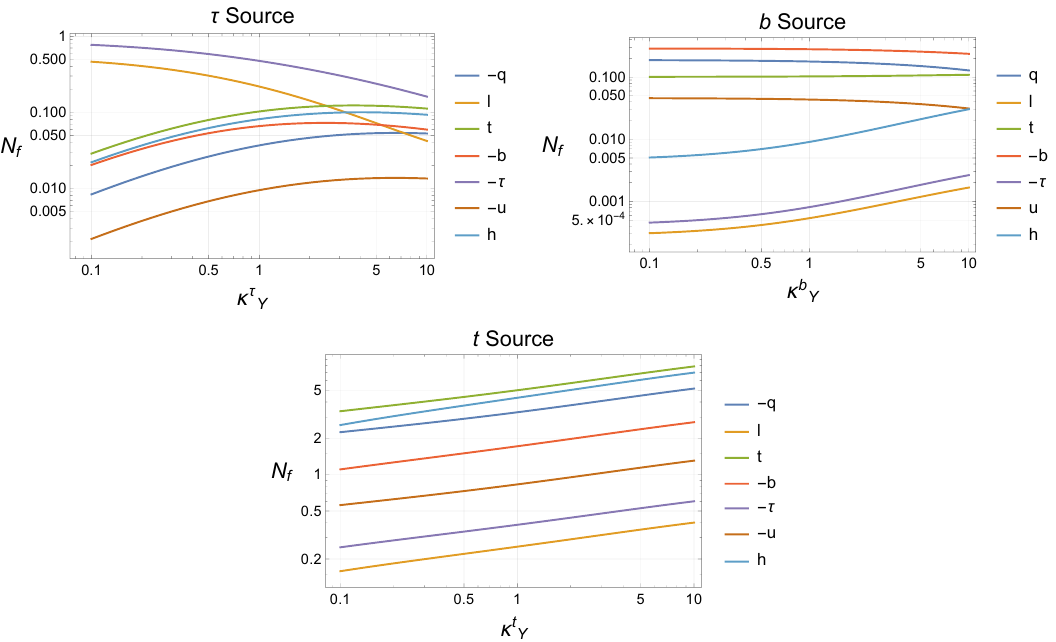
Figure 2. Particle densities integrated in the symmetric phase N f prior to weak sphaleron action as a function of the Yukawa rate modifier κ f . In each subfigure, a different source is turned on, Y and the corresponding fermion’s Yukawa rate is modified.